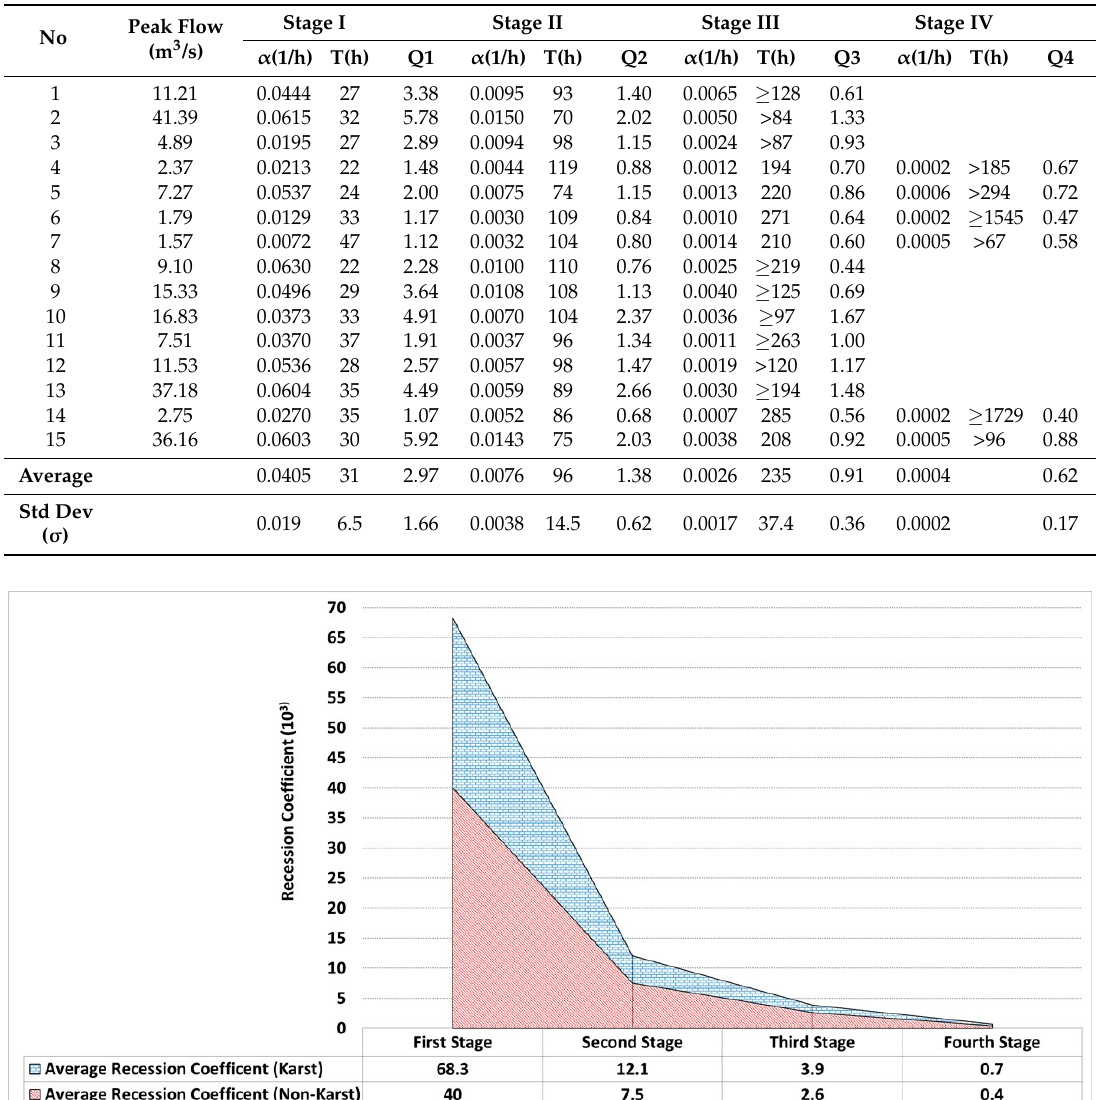
Table 3. Table of recession coefficients and recession stages for Gaojiaping Watershed.